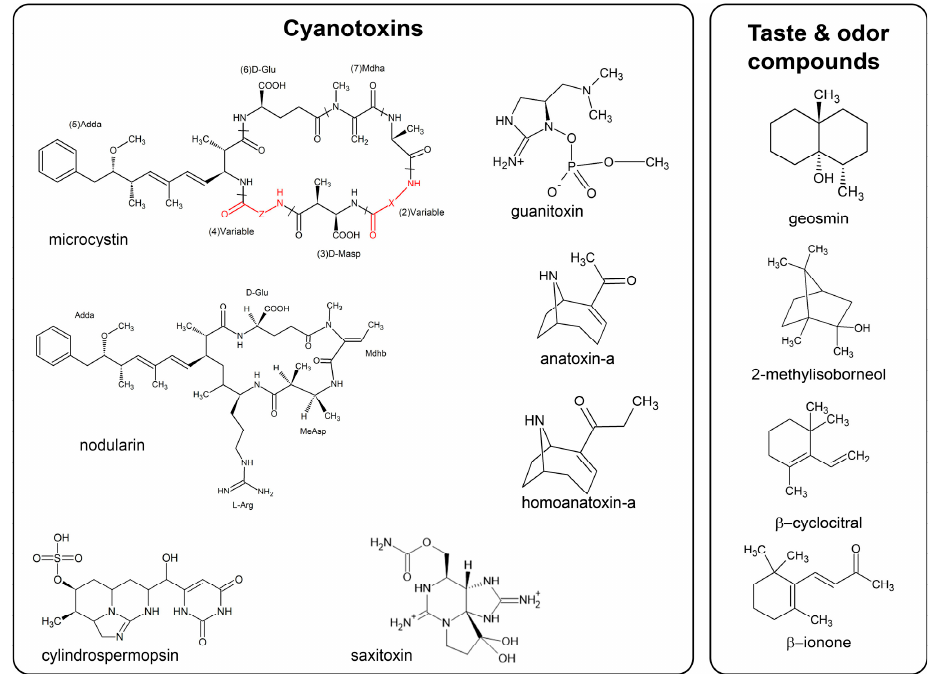
Figure 1. Structures of the cyanotoxins and taste and odor compounds considered in the review. The red part in the microcystin structure shows the positions 2 and 4 of the ring, whose variable amino acids characterize different commonly occurring variants. Further aminoacid substitutions and modifications throughout the microcystins ring generate additional variants.